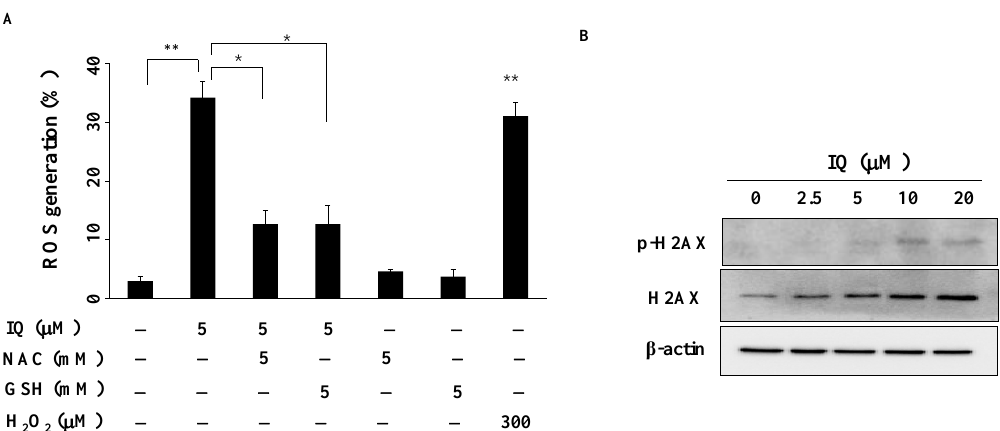
Figure 4. IQ increases reactive oxygen species (ROS) production. ( A ) Statistical analysis of ROS generation in SCC4 cells after the treatment with only 5 µ M of IQ for 3 h or in combination with 5 mM of N -acetylcysteine (NAC) or 5 mM of glutathione (GSH). Cells were stained with carboxy-DCF-DA and analyzed using flow cytometry. Data are expressed as mean ± S.D. ( n = 3). * p < 0.05 and ** p < 0.01. ( B ) IQ-induced H2AX phosphorylation / expression in SCC4 cells.